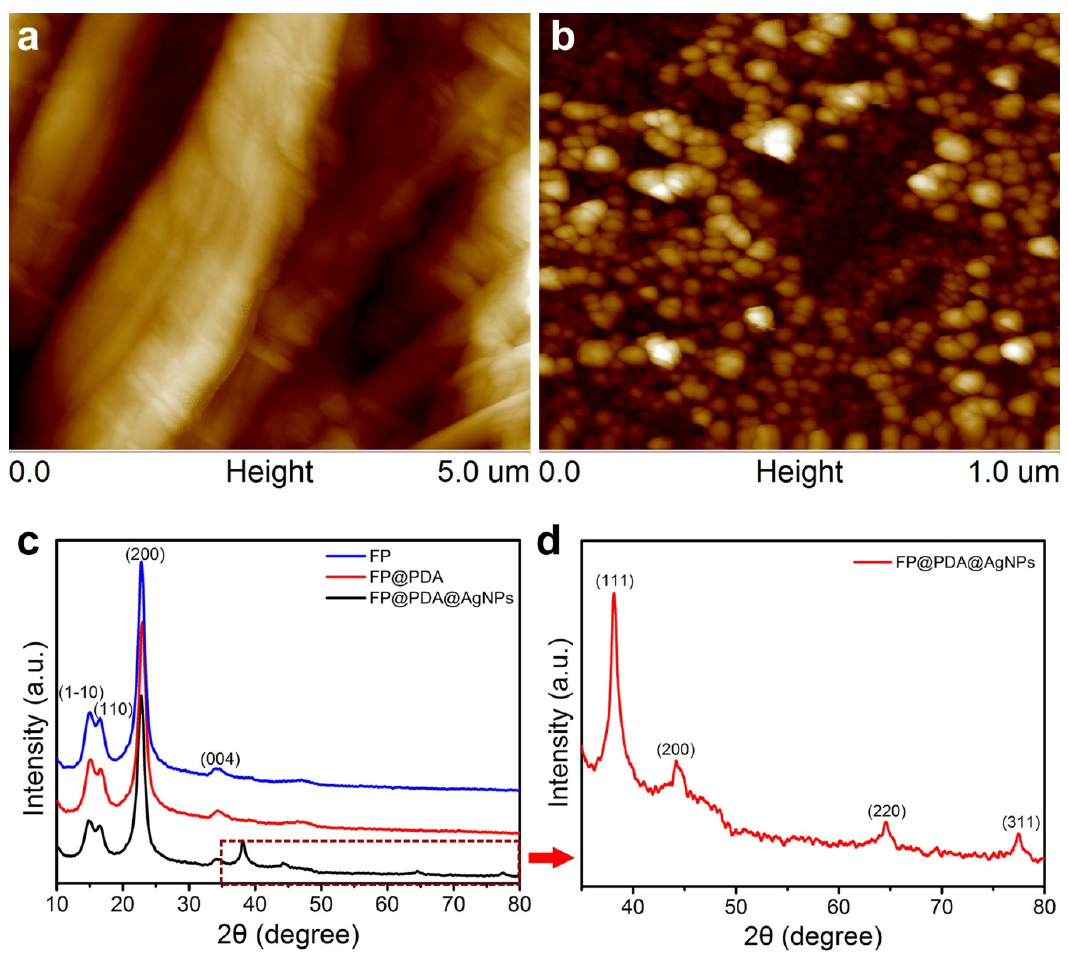
Figure 3. Atomic force microscope (AFM) images of the ( a ) FP strips, and ( b ) FP@PDA@AgNPs strips, and ( c ) X-ray di ff raction (XRD) spectra of the pristine FP, FP@PDA, and FP@PDA@AgNPs strips. ( d )